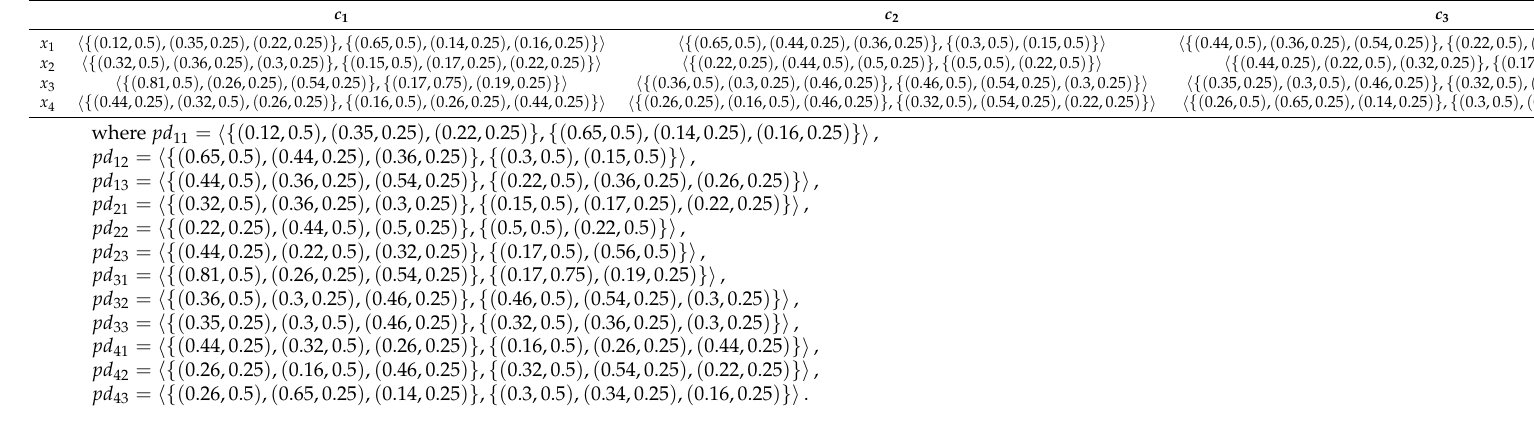
Table 5. The overall evaluation matrix R